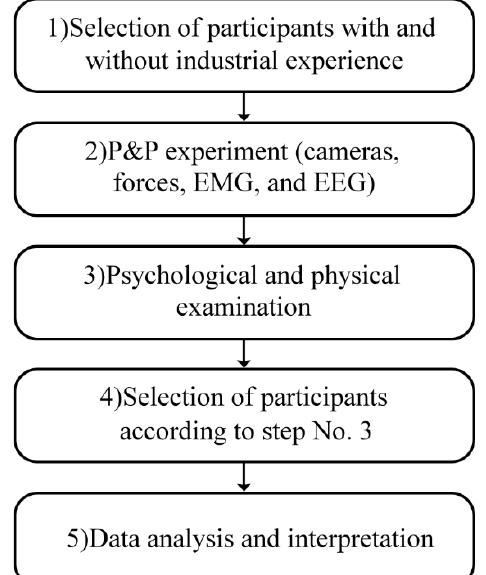
Figure 1. Flowchart of the experiment.